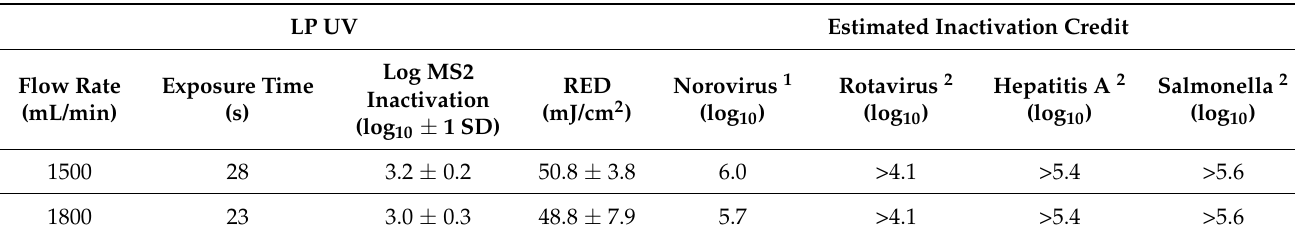
Table 3. Disinfection performance of flow-through LP UV inactivation of septic effluent ( n = 4) for (UVT 254 < 5.2%). RED is the reduction equivalent dose determined from biodosimetry with the batch